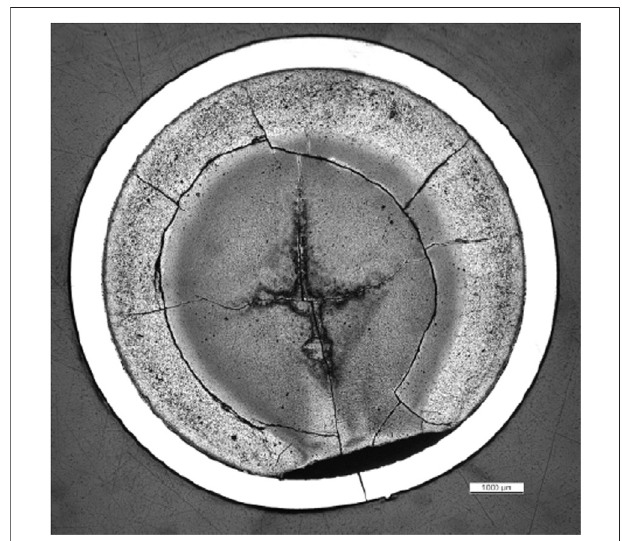
FIGURE 1 | A cross-sectional view of a cladding failed fuel rod (Capps et al., 2015).